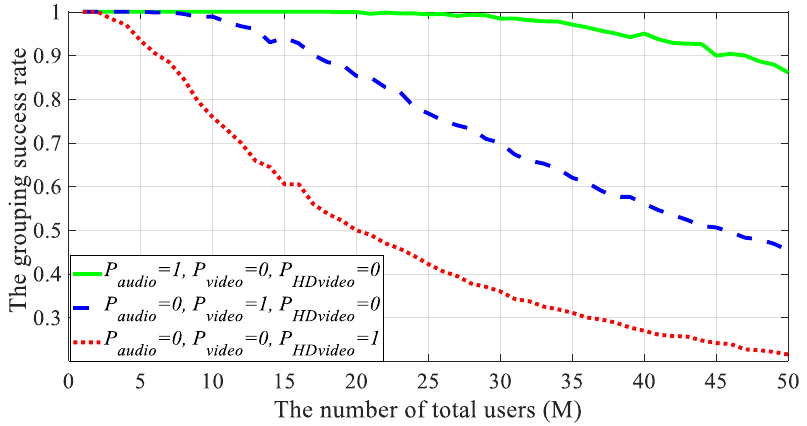
Figure 8. The grouping successful rate of the single relay-allowed modified pilot-based grouping method in scenario 2.